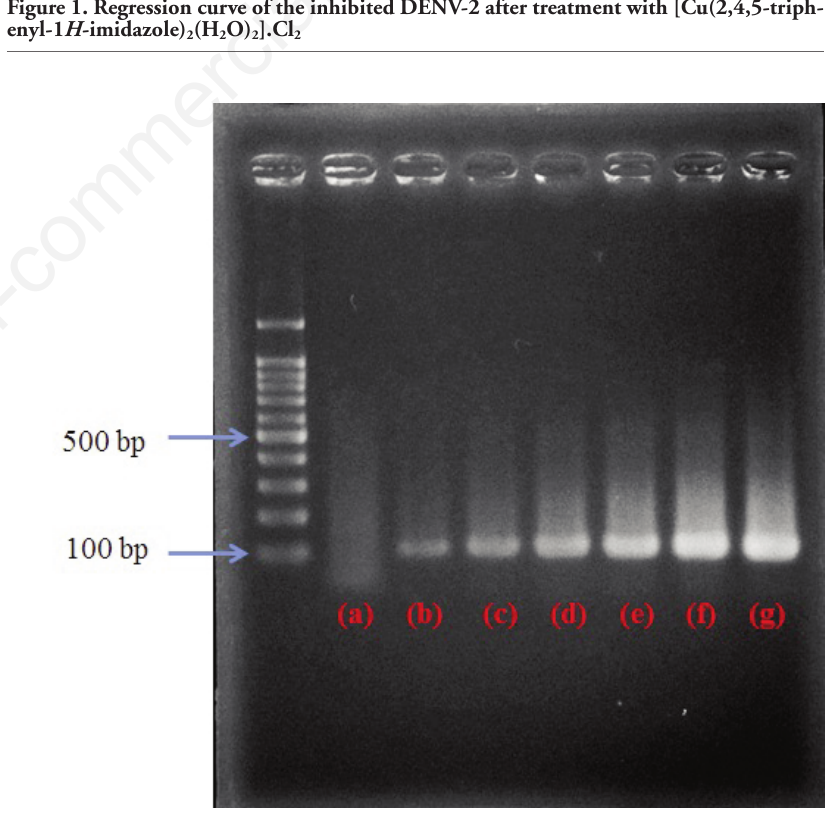
Figure 2. Electrophoresis on 1.5% agarose of RT-PCR after treatment, molecular weight marker (100 bp), (a) negative control, (b) 200 µg/mL, (c) 100 µg/mL, (d) 50 µg/mL, (e) 25 µg/mL, (f) 12.5 µg/mL, and (g)6.25